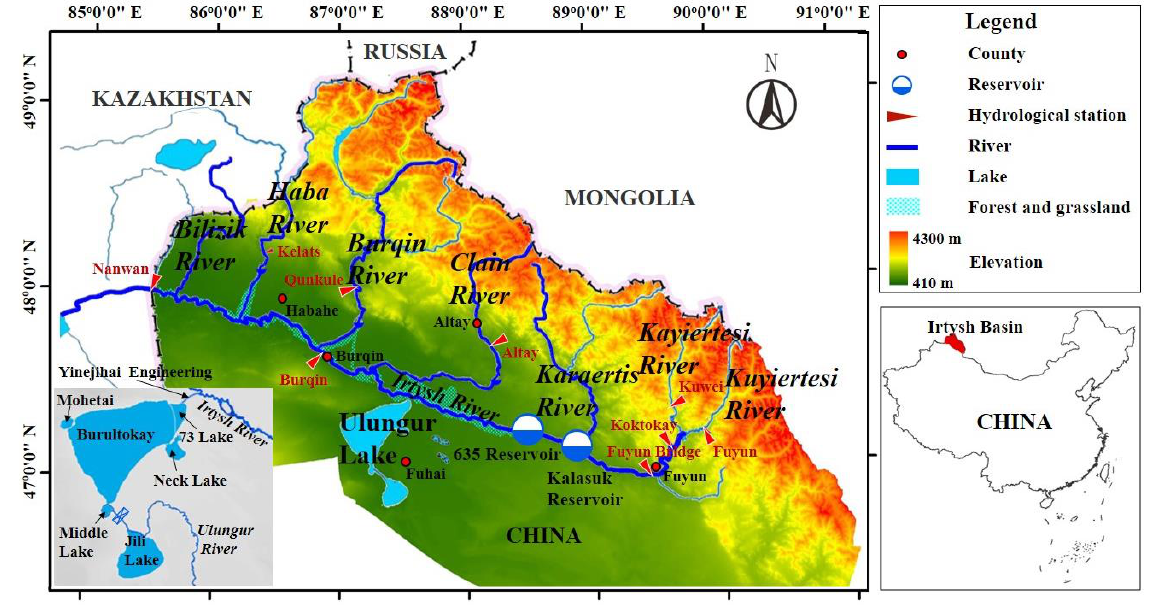
Figure 1. Location of Irtysh River Basin in China.